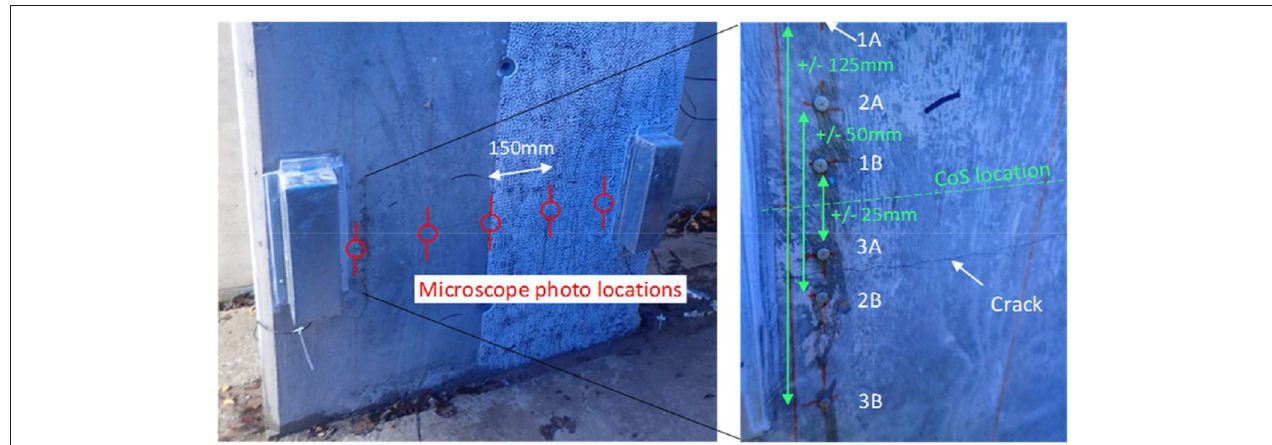
FIGURE 11 | Location of DEMEC pips and microscope images for crack width